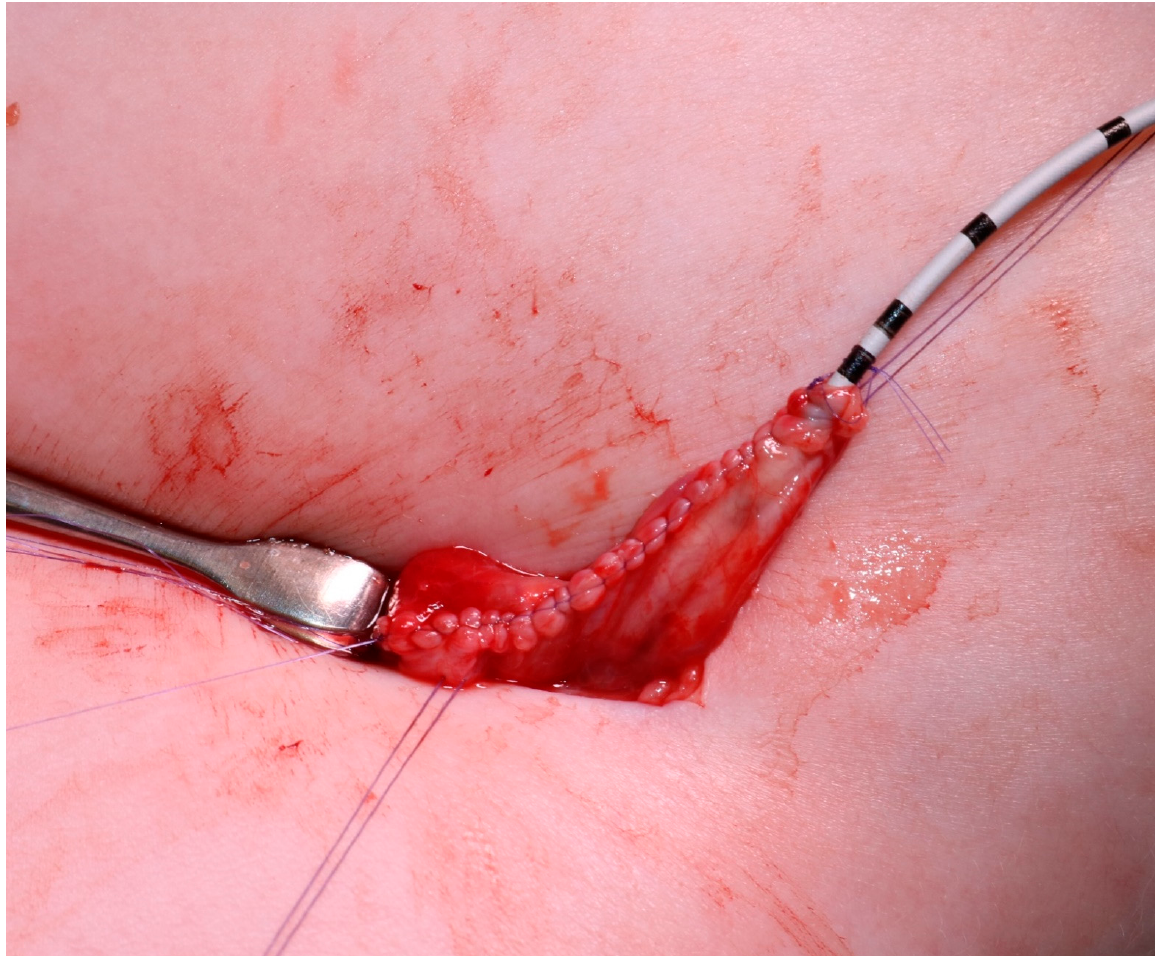
Figure 5. Final aspect of the reconstructed pelvis, with an external ureteropelvic stent emerging from one end of the suture.